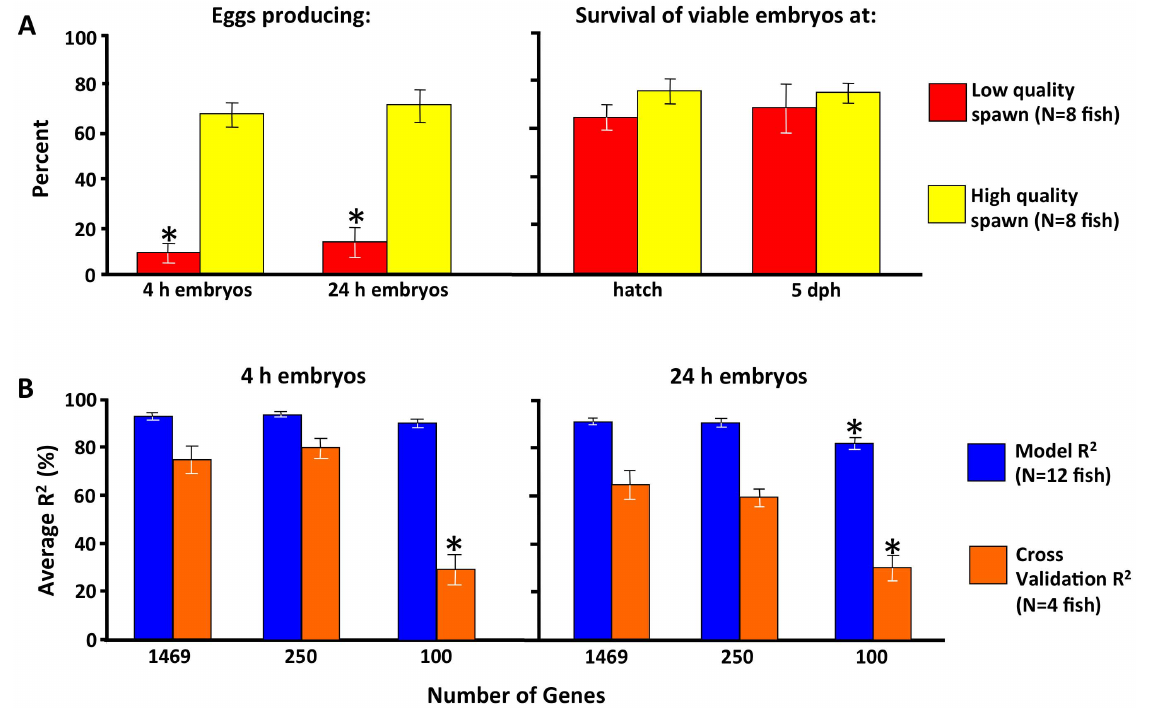
Figure 1. Results of analyses of spawn quality and its relationship to ovarian gene transcript profiles. (A) Mean percent of eggs producing viable 4 hour (h) and 24 h embryos, percent of viable 24 h embryos to hatch, and percent of hatched embryos surviving to 5 days post- hatch (dph). Vertical brackets indicate S.E.M. and asterisks indicate a significant difference ( P , 0.001) from values for high quality spawns. (B) Results of artificial neural network (ANN) analyses of the microarray data. Bars indicate mean R 2 values for 20 ANN models, vertical brackets indicate S.E.M., and asterisks indicate a significant difference from the value obtained using the top 1469 genes ( P , 0.05).